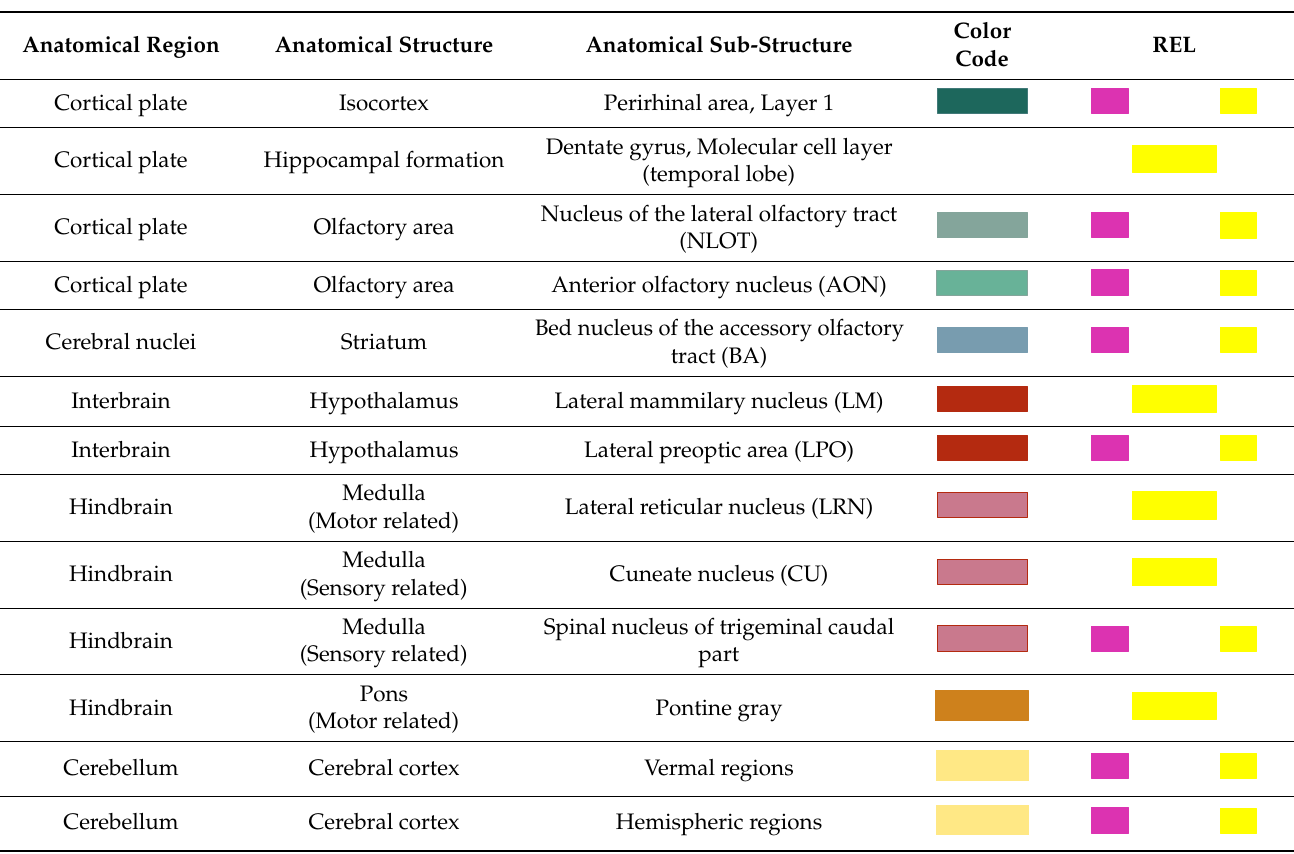
Table 1. Summary of the anatomical substructures characterized by a medium to high relative expression level of Tsen54- lacZ gene reporter. Anatomical brain structures and substructures characterized by high and intermediate relative expres- sion level of Tsen54-lacZ reporter gene are listed. The color code for the indicated regions is extrapolated from Allen Brain Atlas BrainExplorer 2 software. This color code was applied for virtual reconstruction of 3D Tsen54 gene expression pat- tern in the murine brain (Movie S5); REL — relative expression level of the reporter gene activity. Yellow indicates areas of subregions with highest and magenta with intermediate gene expression levels.